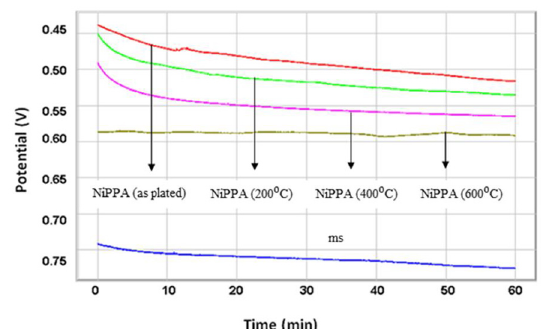
Figure 7. OCP curves for ms and NiPPA coatings (as plated and heat treated) in 3.5% NaCl solution.